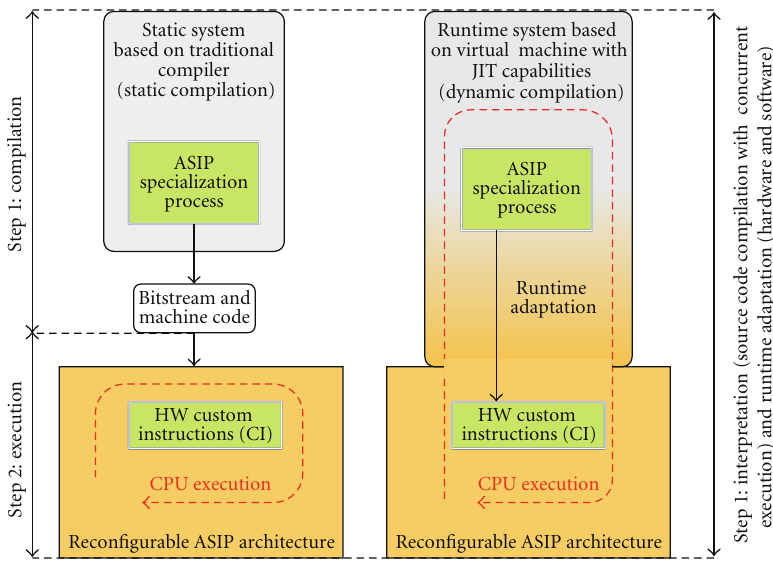
Figure 1: Overview of ASIP specialization process for conventional static and runtime